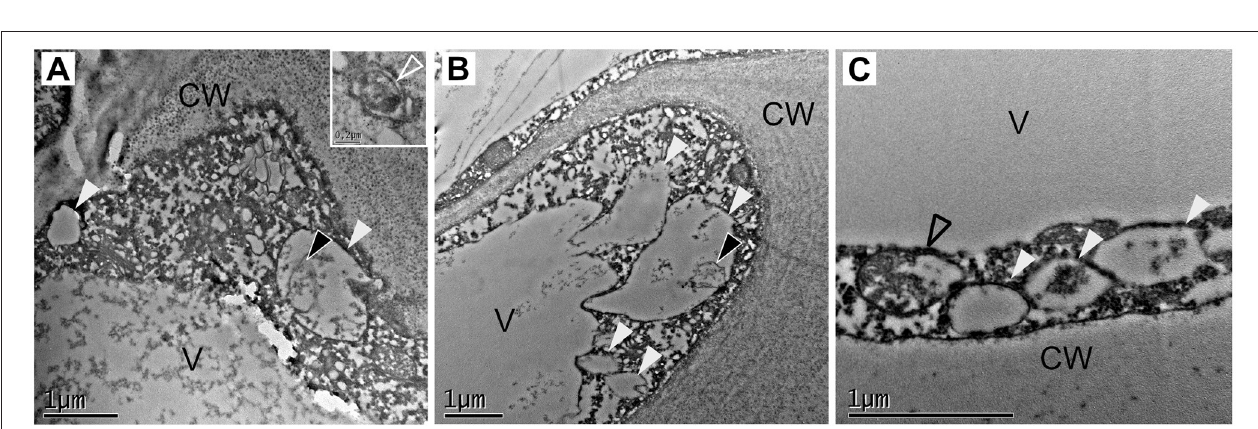
FIGURE 4 | Identification of autophagy-related structures in F x ananassa receptacle along ripening. TEM micrographs from receptacle cortical cells showing autophagy-related structures. (A) Green receptacle cell, (B) white receptacle cell, and (C) red receptacle cell. White arrowheads: single membrane compartments with degraded content, black arrowheads: autophagic bodies, empty black arrowhead: disassembling mitochondria. CW, cell wall; V, Vacuole.